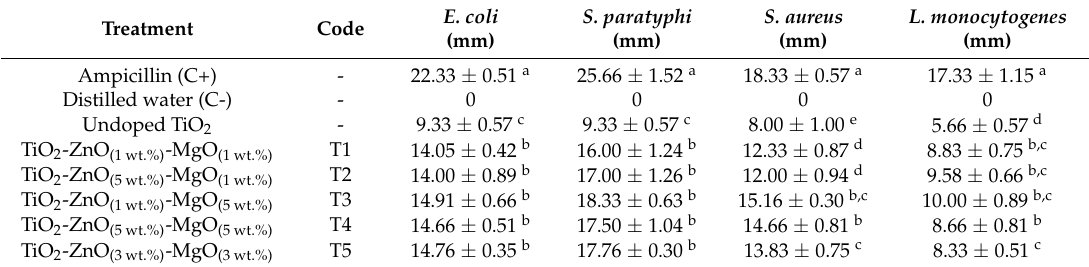
Table 4. Antimicrobial activity of pure TiO 2 and mixed oxide (TiO 2 -ZnO-MgO) materials. Treatment